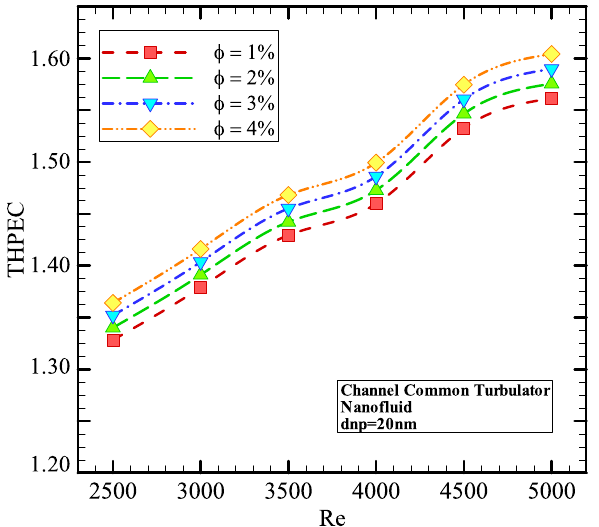
Figure 14. The THPEC variation versus Re in helical heat exchanger equipped with common turbulators saturated with nanofluid ( d np = 20 nm) in different volume fractions.